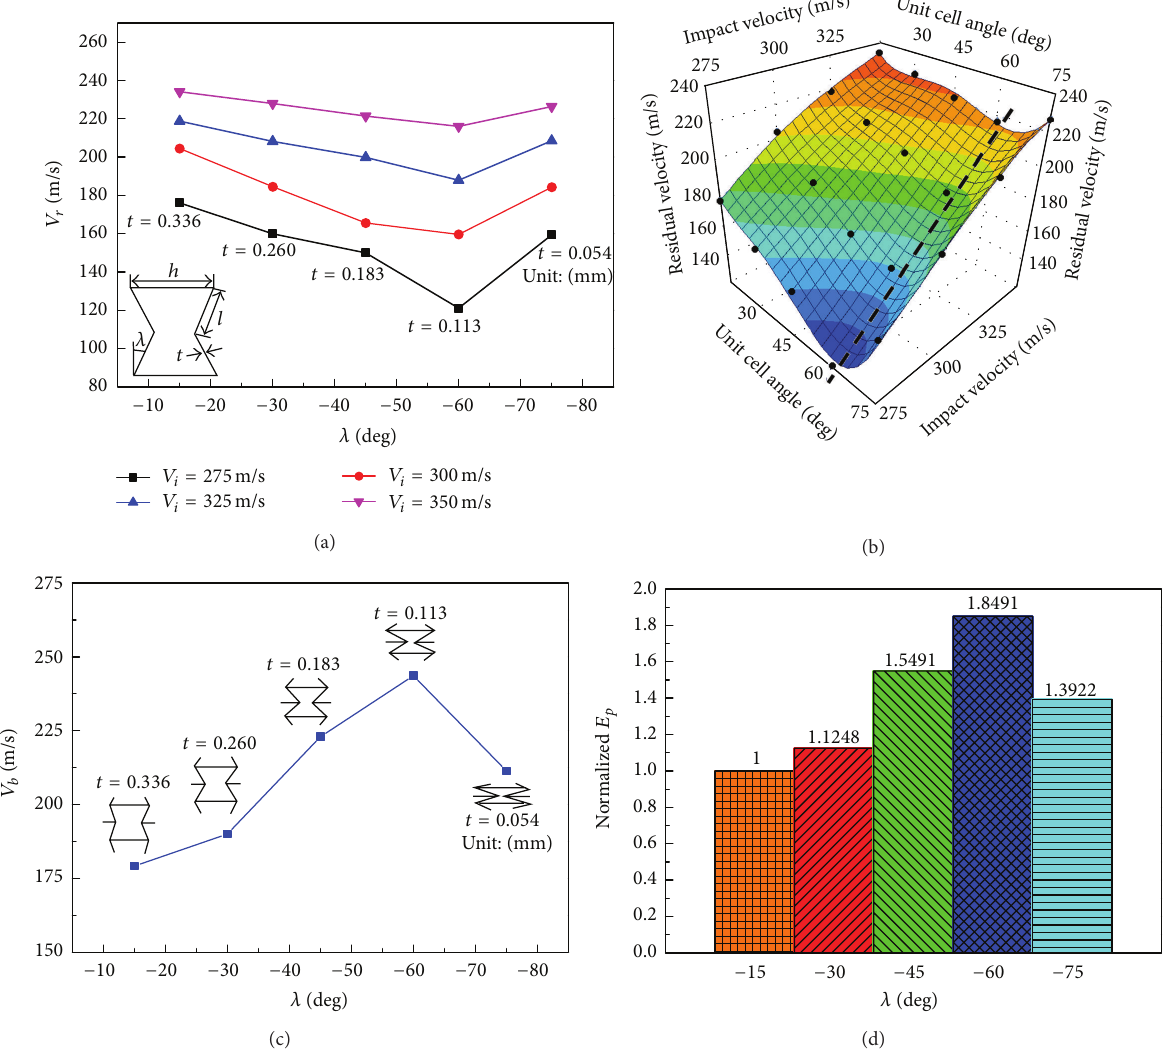
Figure 18: Effects of reentrant unit cell angle and wall thickness on the ballistic responses of auxetic HSPs: (a) residual velocity variations with varied cell angle and wall thickness at different impact velocities; (b) quartic polynomial approximation surface of residual velocity (The bold black dots in the plot show the training points); (c) ballistic limit versus unit cell angle; and (d) normalized minimum perforation energy versus unit cell angle. (All numerical specimens have 𝑇 𝑓 = 1.0 mm, 𝑇 𝑐 = 50 mm, 𝜌 = 0.15 , ℎ = 8 mm, and 𝑙 = 4 mm).